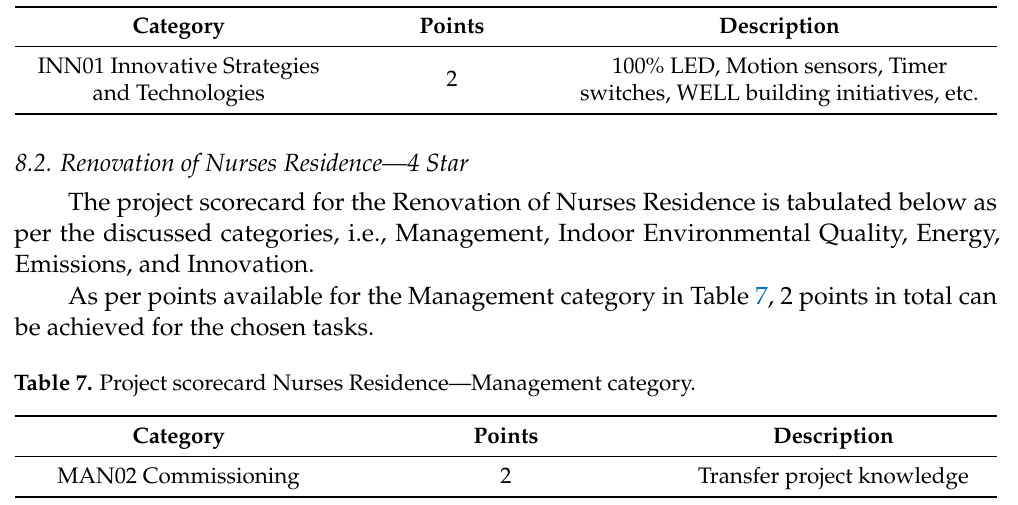
Table 6. Project scorecard EMS College—Innovation category.